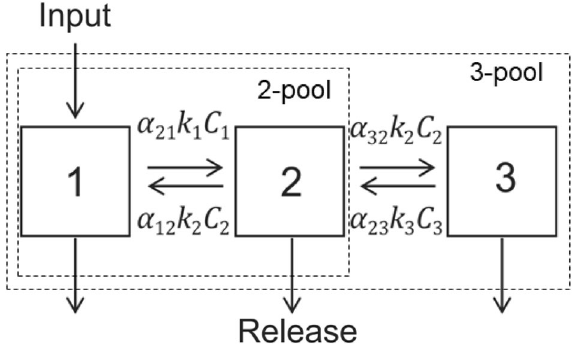
Figure 2. Conceptual 2- and 3-pool models with series C flow, feedback between pools, and respiration loss from all